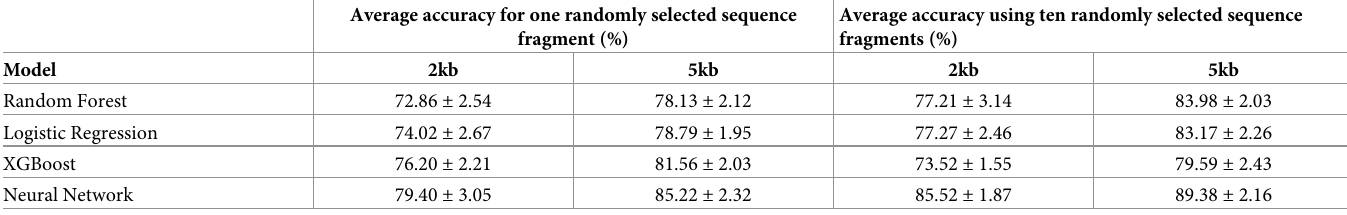
Table 1. Accuracy of ML models built for classifying plasmid and chromosome sequences using 6-mers as features � . Average accuracy for one randomly selected sequence fragment